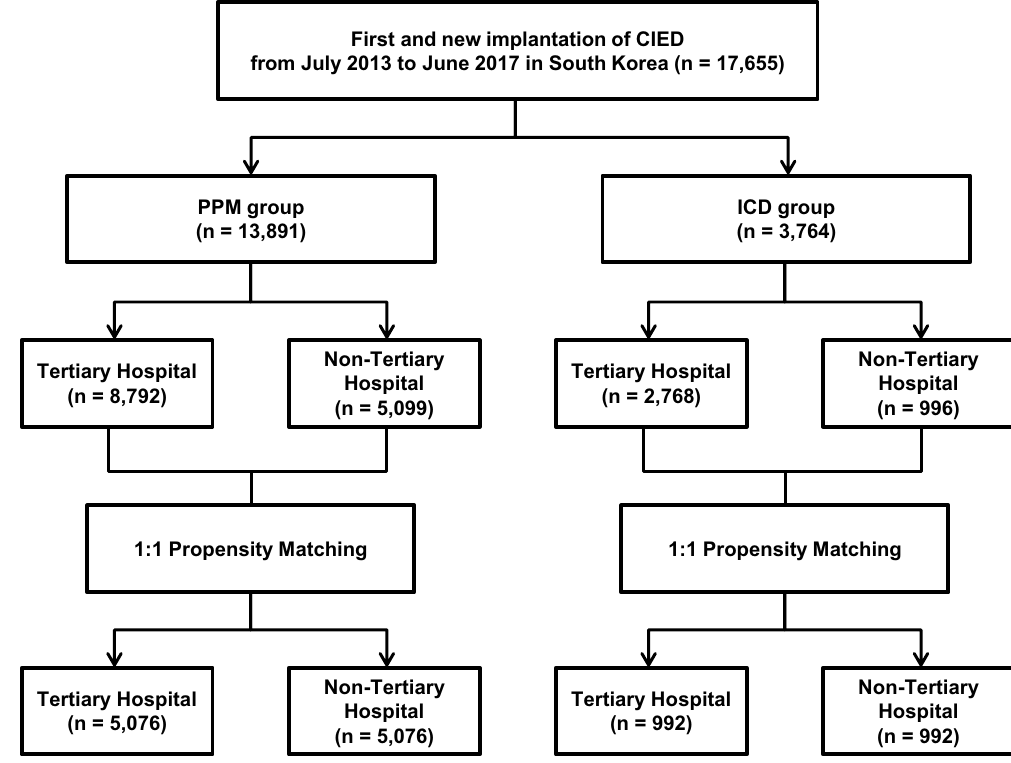
Figure 1. Diagrammatic representation of the study. CIED, cardiac implantable electronic device; ICD, implantable cardioverter-defibrillator; PPM, permanent